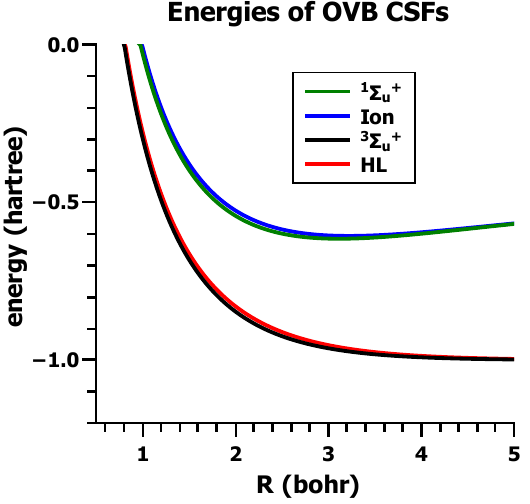
Figure 23. The energy curves for the orthogonal configurational state